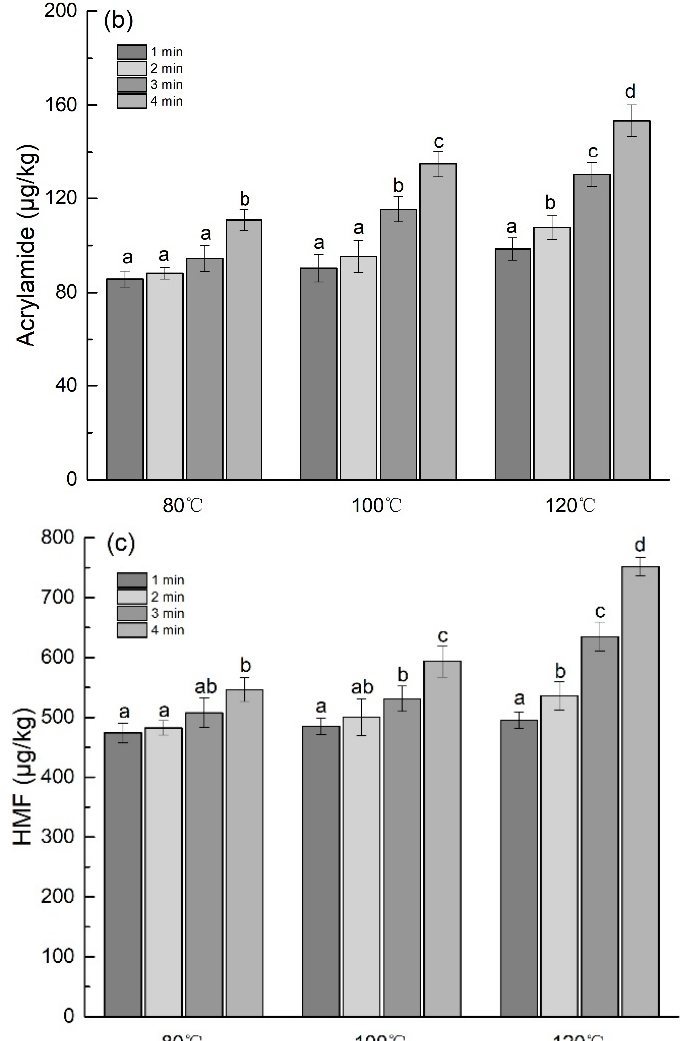
Figure 4. Effect of infrared pretreatment temperature and time on oil content ( a ), acrylamide ( b ), and 5-hydroxymethylfurfural (HMF) ( c ) in FDT. The different lowercase letters represent significant difference ( p < 0.05).